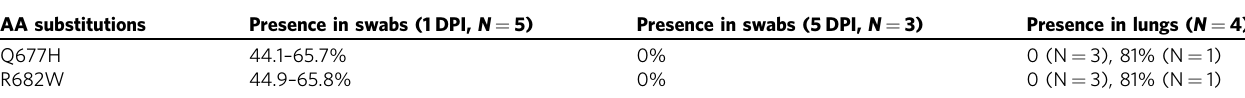
Table 2 Presence of substitutions Q677H and R682W in swabs and lung tissue of hamsters directly inoculated with B.1.351.